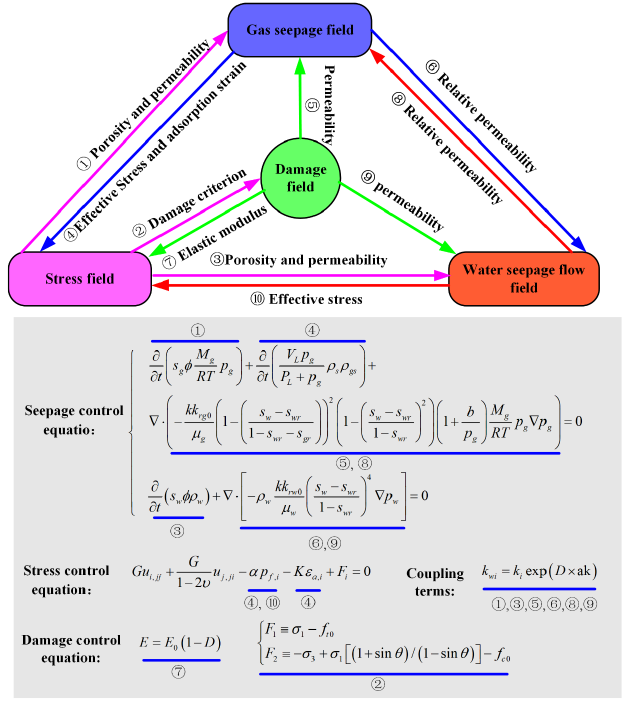
Figure 1. Coupling relations of different physical fields.